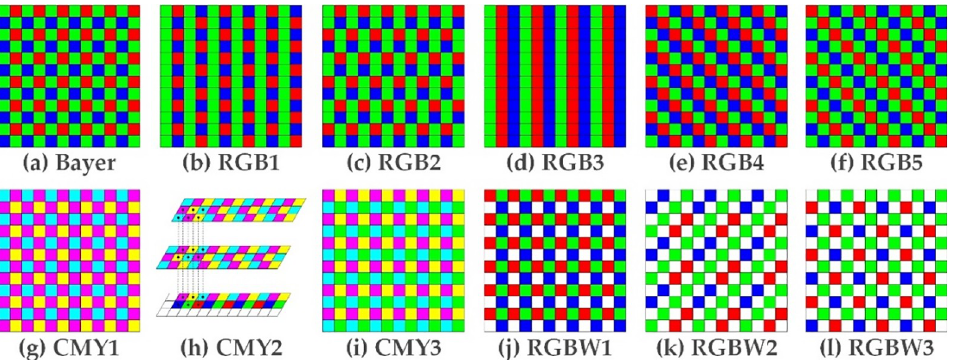
Fig 1. Test CFAs for performance comparison: (a)–(f) RGB-, (g)–(i) CMY-, and (j)–(l) RGBW-based CFAs.